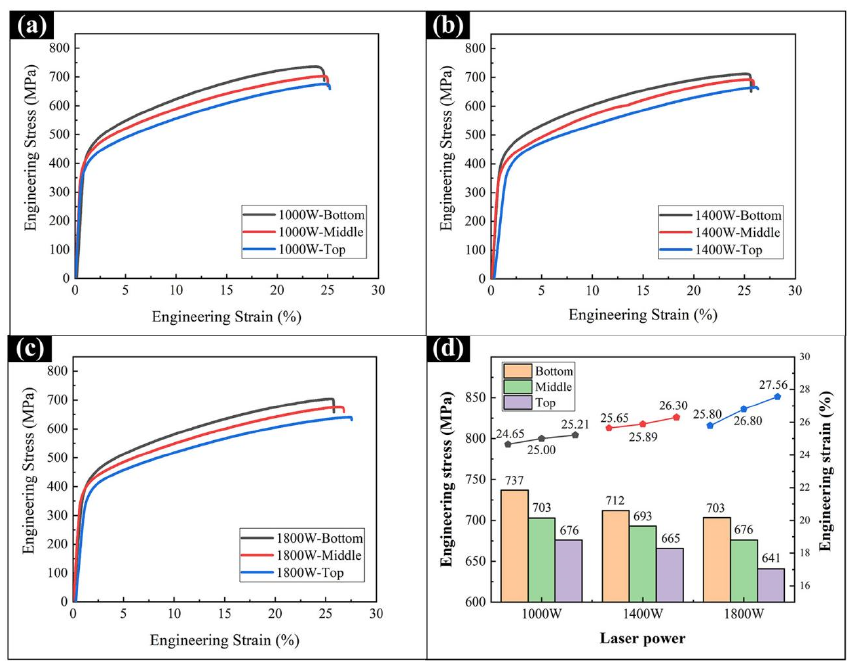
Figure 9. The tensile stress-strain curves of the Al 0.5 FeCoCrNi HEA samples manufactured by LMD at different powers and different locations: ( a ) 1000 W; ( b ) 1400 W; ( c ) 1800 W. ( d ) Average strength and strain.